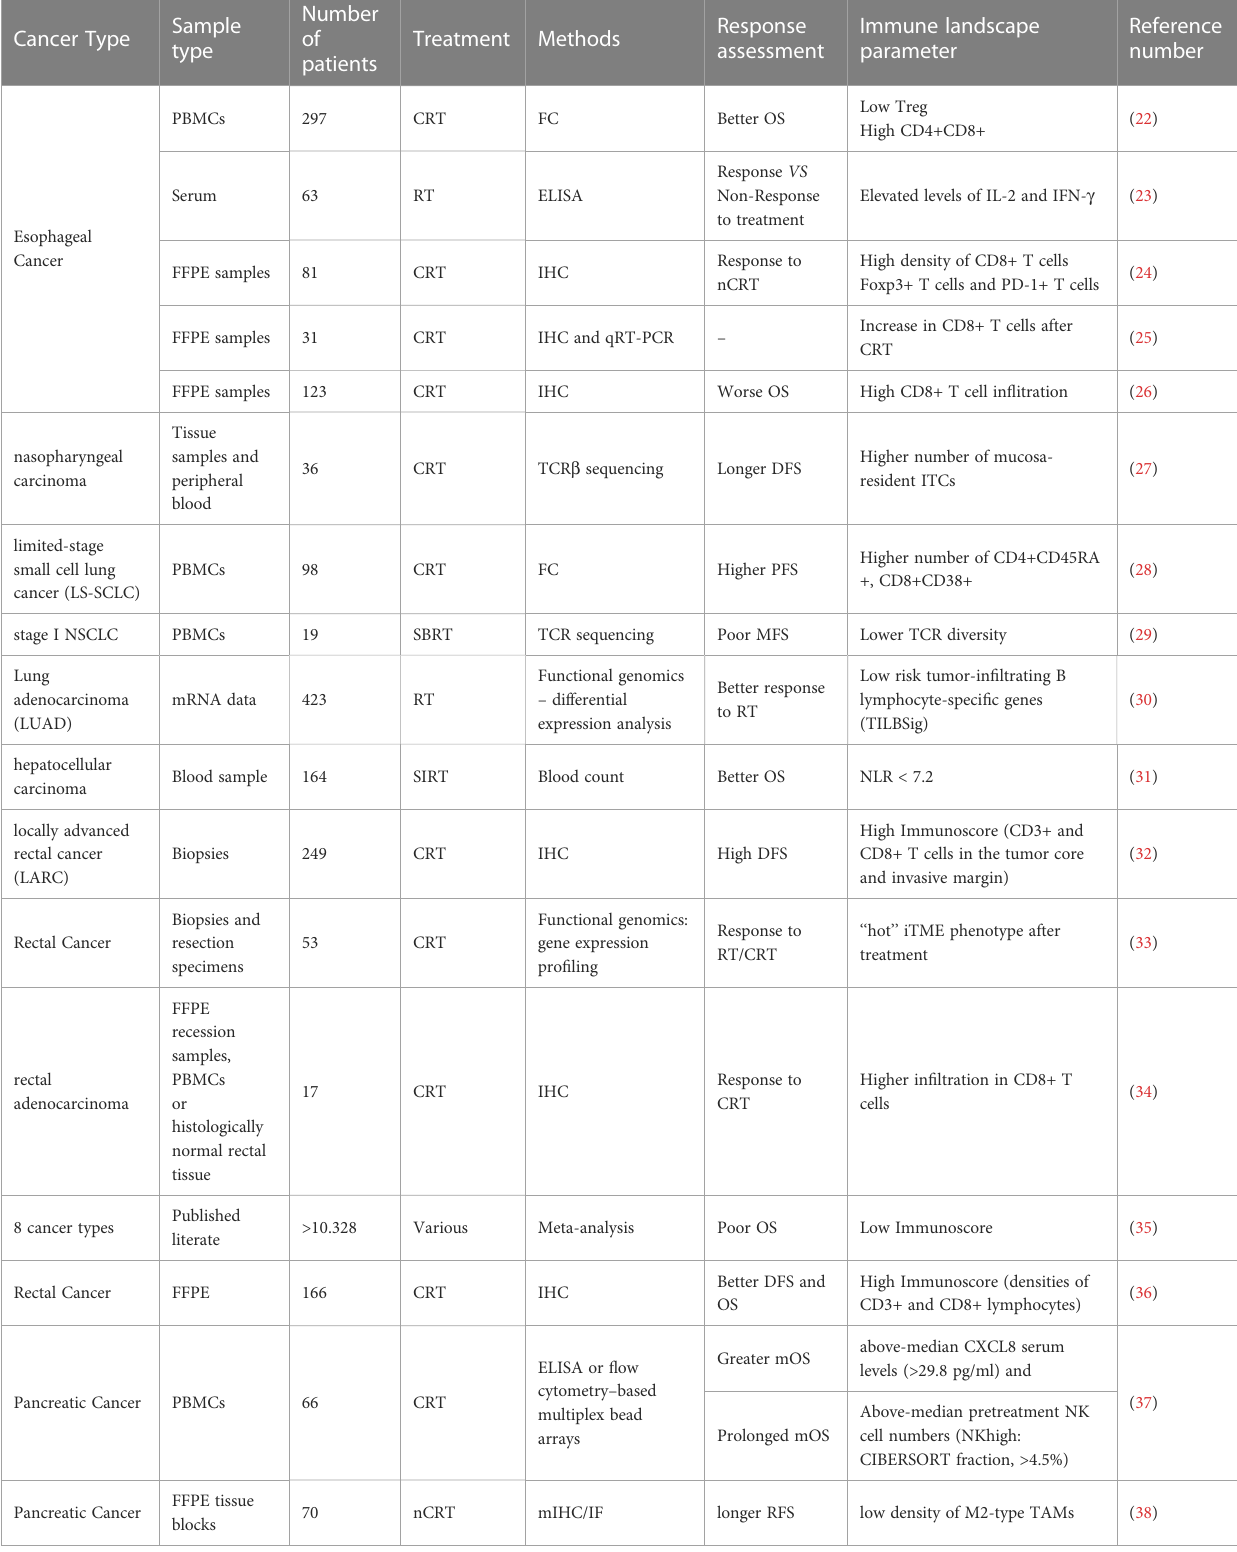
TABLE 1 Immune landscape elements associated with prediction and prognosis in patients that underwent